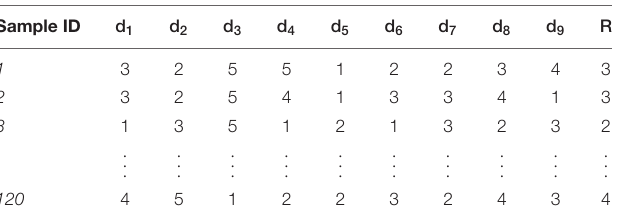
TABLE 1 | Discrete samples of assessment